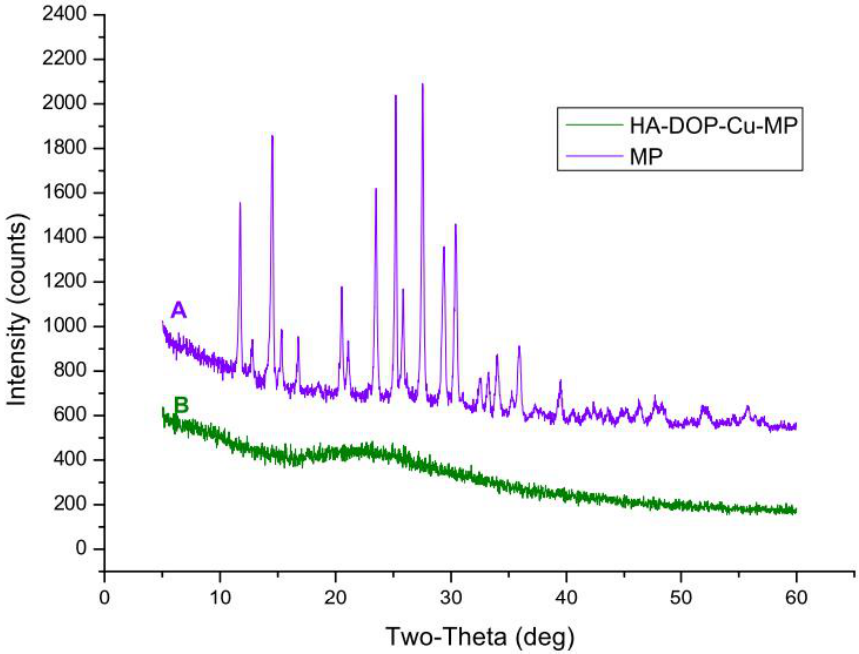
Figure 6. X-ray diffraction (XRD) patterns for ( A ) 6-MP and ( B ) HA-DOP-Cu-MP. Figure 6. X-ray di ff raction (XRD) patterns for ( A ) 6-MP and ( B )